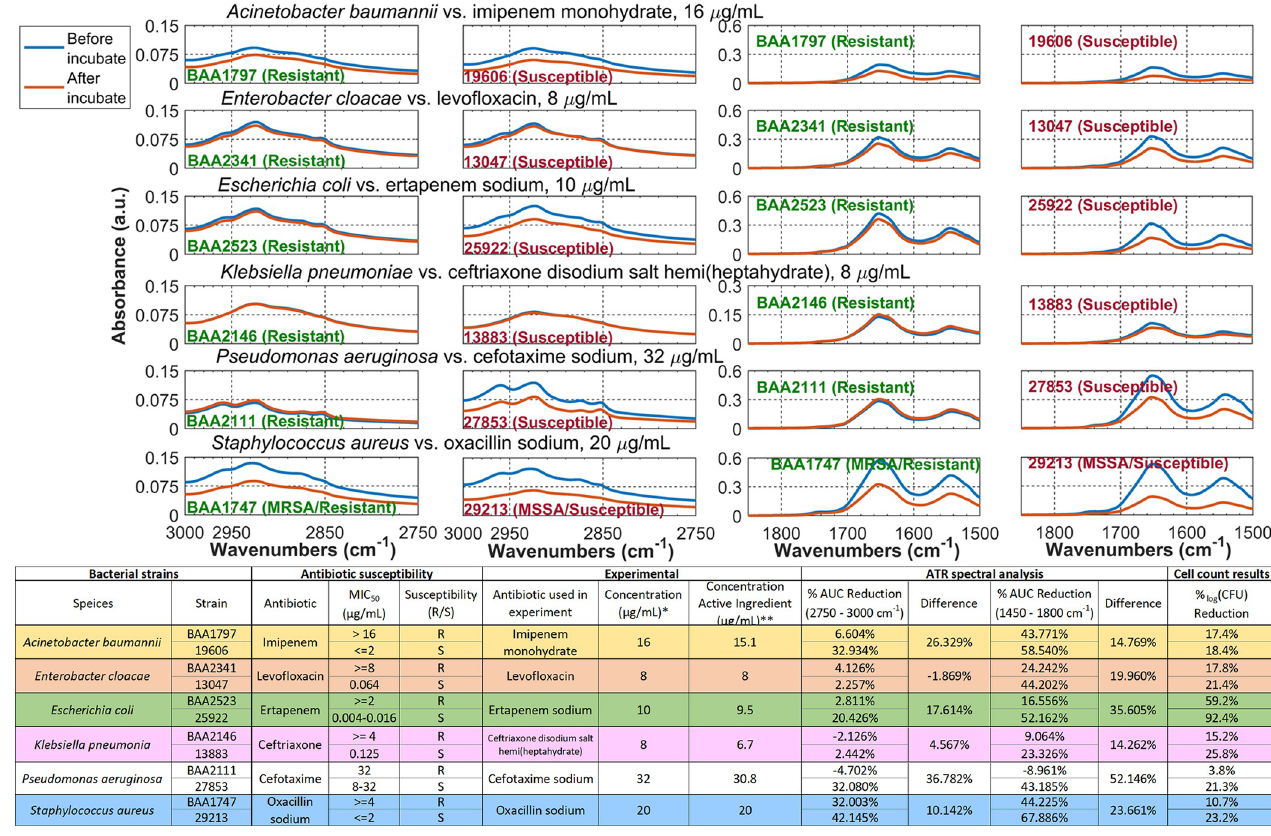
Fig 2. (Top) Zoom-in view to the two highlighted regions in each strain from Fig 1 to show the common spectral change trend between MDR and antimicrobial-susceptible strains in six species. (Bottom) Table summary (1) Strain designation, antimicrobial susceptibility to six different antimicrobials, MIC 50 values and the sources for the MIC 50 values. (2) Reagent used in experiment and the concentration of active ingredient. � All antimicrobial solution is prepared in 5% dextrose saline. �� Estimated concentration of antimicrobial in the prepared solution. (3) Area Under the Curve (AUC) calculation for each spectrum. (4) # of viable colonies determined by quantitative overnight culture for each strain, before and after antimicrobial